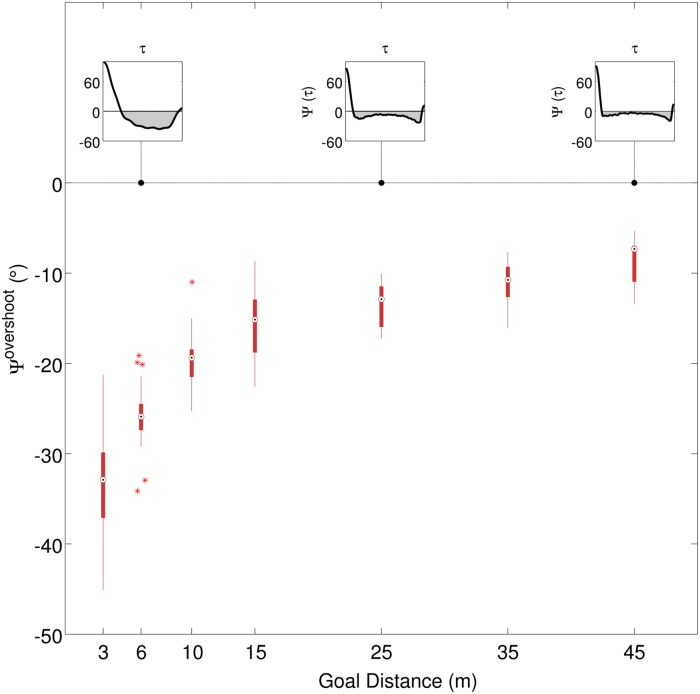
Overshoot in bearing angle.Ψovershoot as a function of goal distance. Box-plot whiskers represent 1.5 times the interquartile range, red crosses indicate outliers. Note that Ψovershoot was calculated from the part of the trial after the crossover point; insets show this as the shaded region for goals at 6m, 25m and 45m distance.